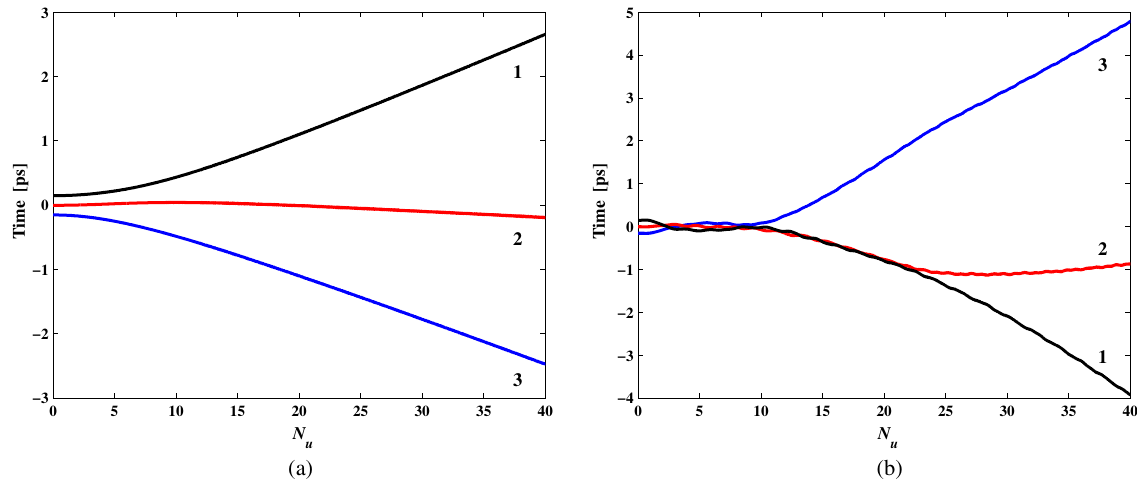
FIG. 3. NMI for three macrocharges of 0.5 nC each, moving in the undulator. Fast spreading with the negative guiding field (a) and close motion of two particles presenting a compact “ cluster ” while the third particle moves away of them presenting a spreading “ tail ” in a strong positive guiding field (b).